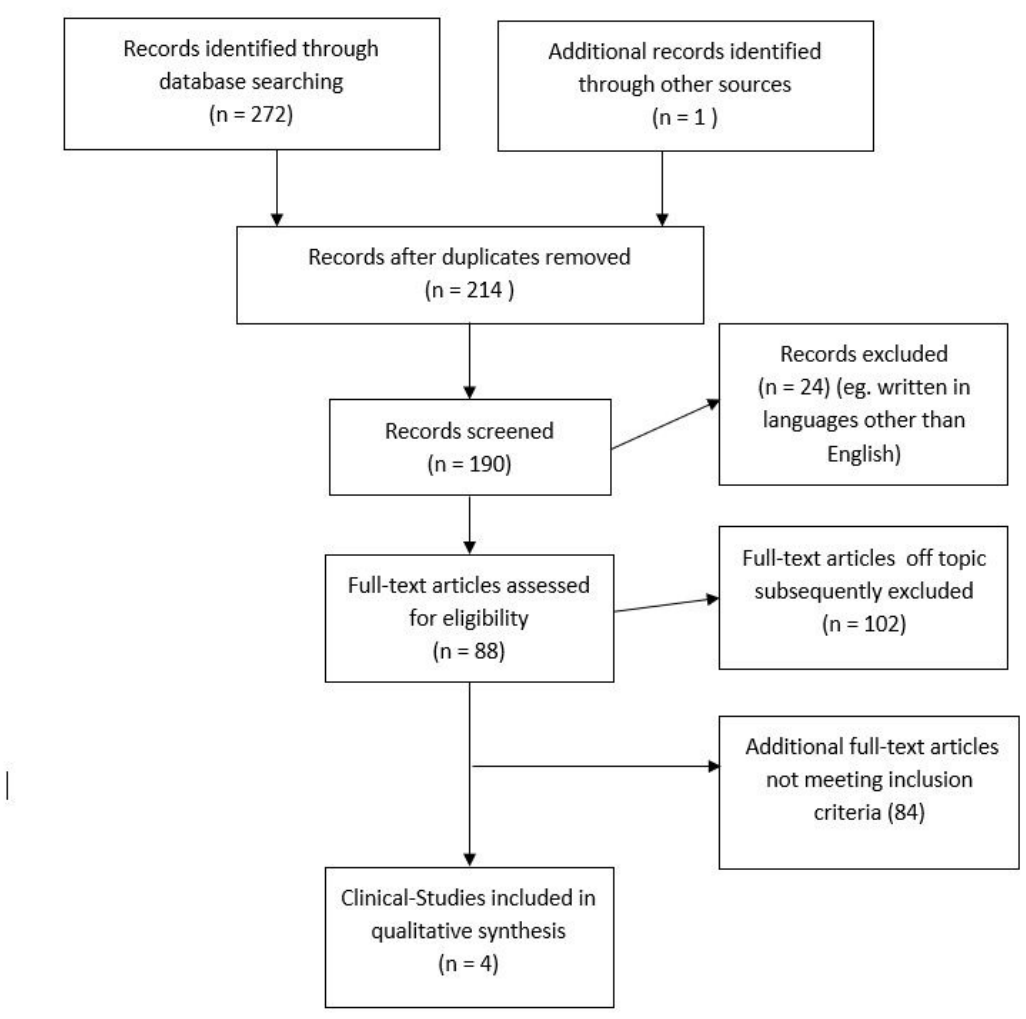
Figure 2. Stages of the screening process about BUP and suicidal behavior.